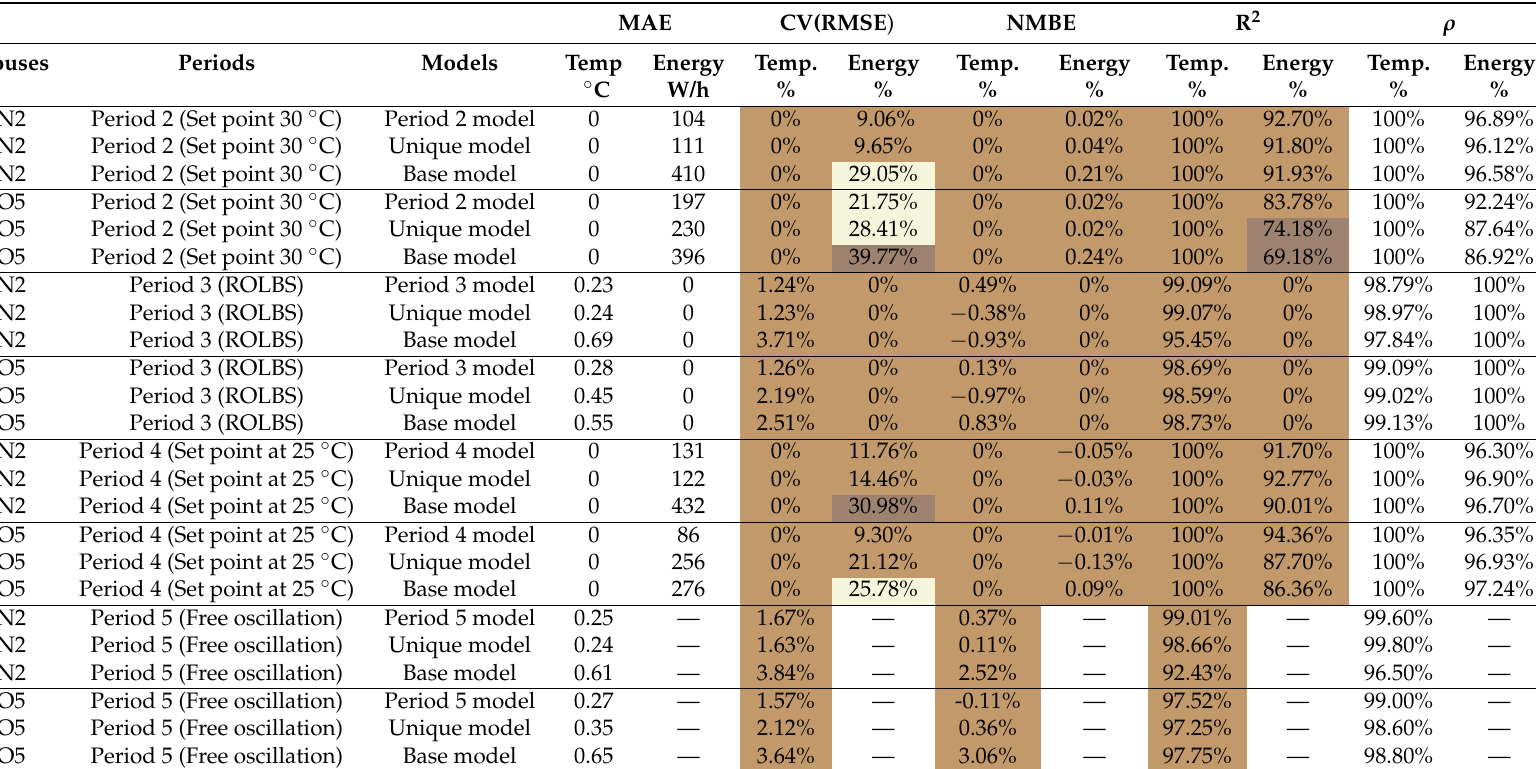
Table 6. Compilation of results for dwellings N2 and O5. Thermal zones that satisfy the IPMVP standards.